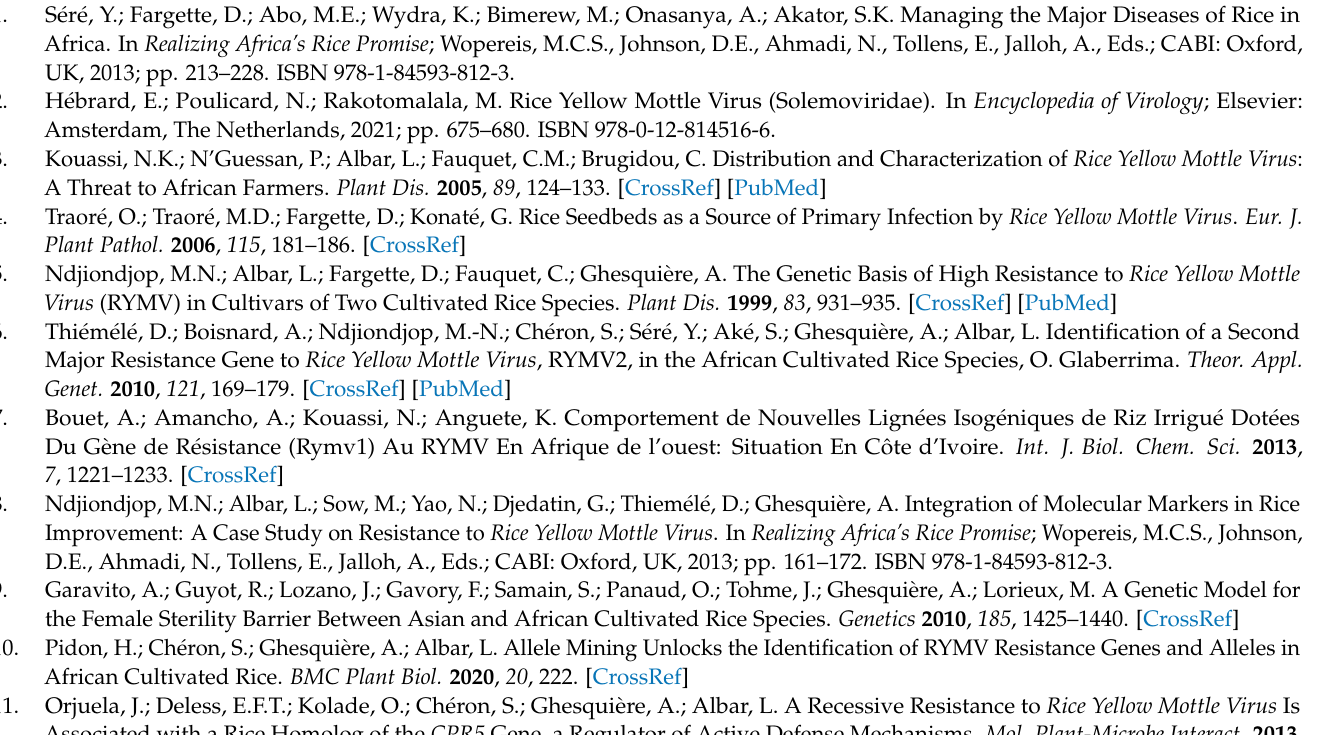
blue. Genomic numbering was indicated based on the reference isolate CIa. Fully sequenced isolates used to validate the molecular tools designed in this study are indicated by black squares. Figure S2: Left panel. Major and minor RT-PCR profiles obtained using F1731E/2365R (lines 2, 4, 6, 8, 10) and F1731T/2365R (lines 3, 5, 7, 9, 11) primer pairs in two independent reactions for